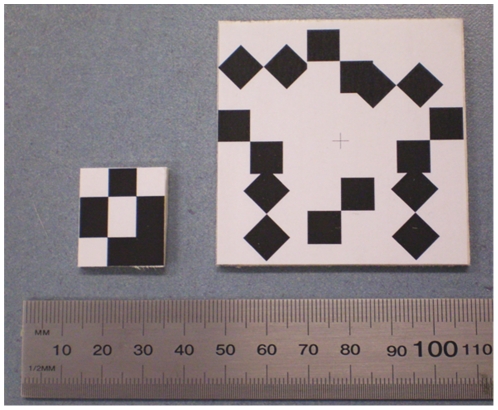
Markers for tracking.The small 3-point marker (left) suitable for rat head tracking, and the larger 8-point marker (right) used as a performance reference. A minimum of three X-points (intersections of black and white regions) are required for six degree-of-freedom pose tracking. The 8-point marker therefore has considerable redundancy for pose estimation.